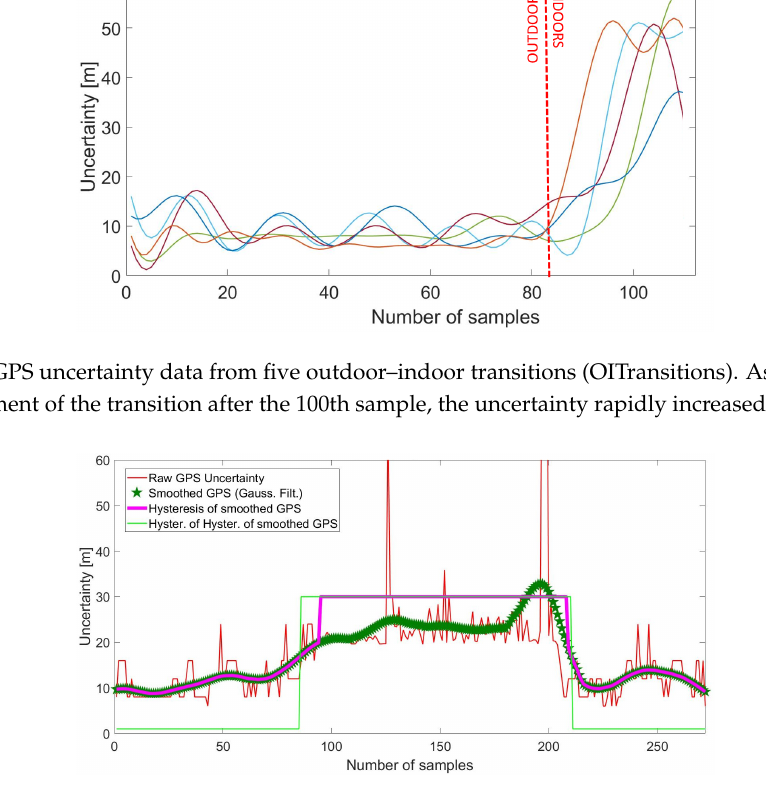
Figure 6. Smoothing and hysteresis thresholding of raw GPS uncertainty